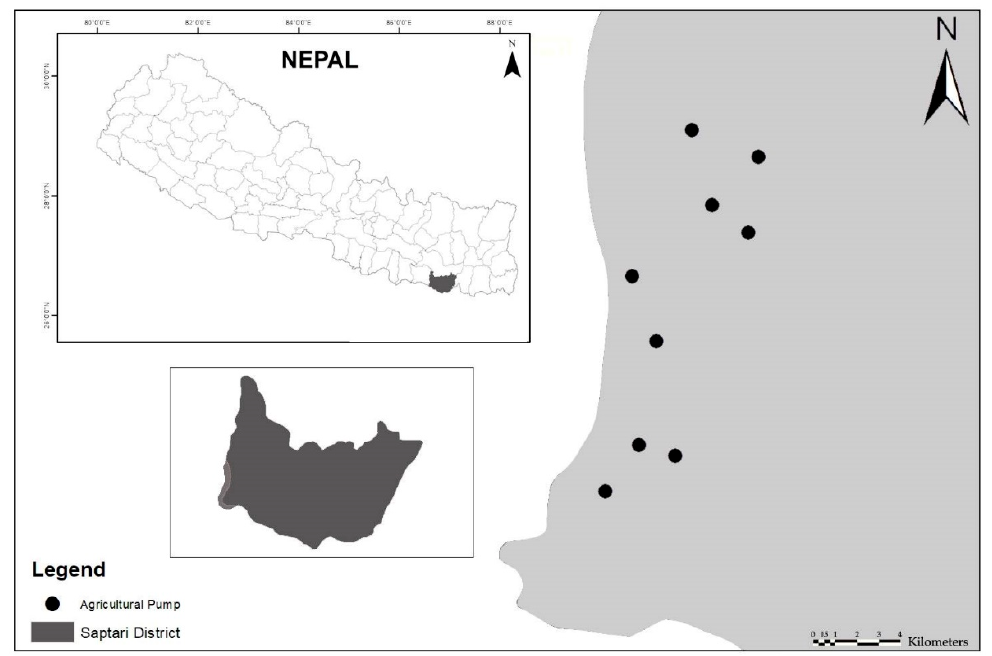
Figure 1. Agricultural pump emissions study area. Black-shaded areas indicate the Saptari district in the Indo-Gangetic Plain; black dots indicate the locations of the individual pumps measured. Atmosphere 2018 , 9 , x FOR PEER REVIEW